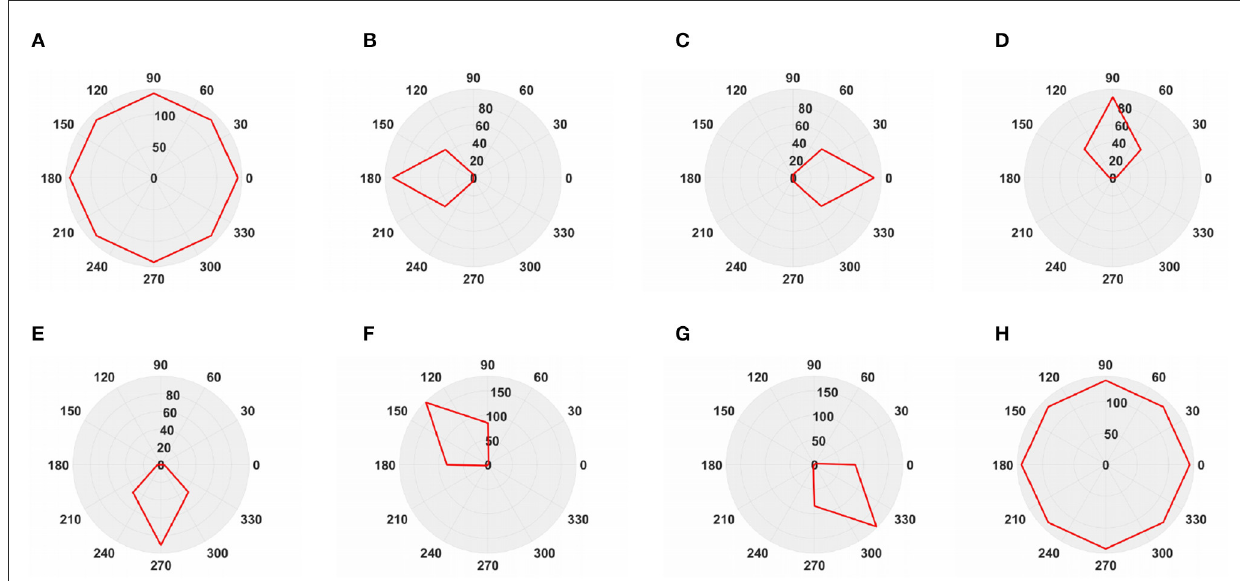
FIGURE7 The output direction of directionally selective fractional-order LGMD collision sensing visual neural network. (A) Object looming motion, (B) object translating leftwards, (C) object translating rightwards, (D) object translating upwards, (E) object translating upwards, (F) object left upper corner motion, (G) object right lower corner motion, and (H) object faraway